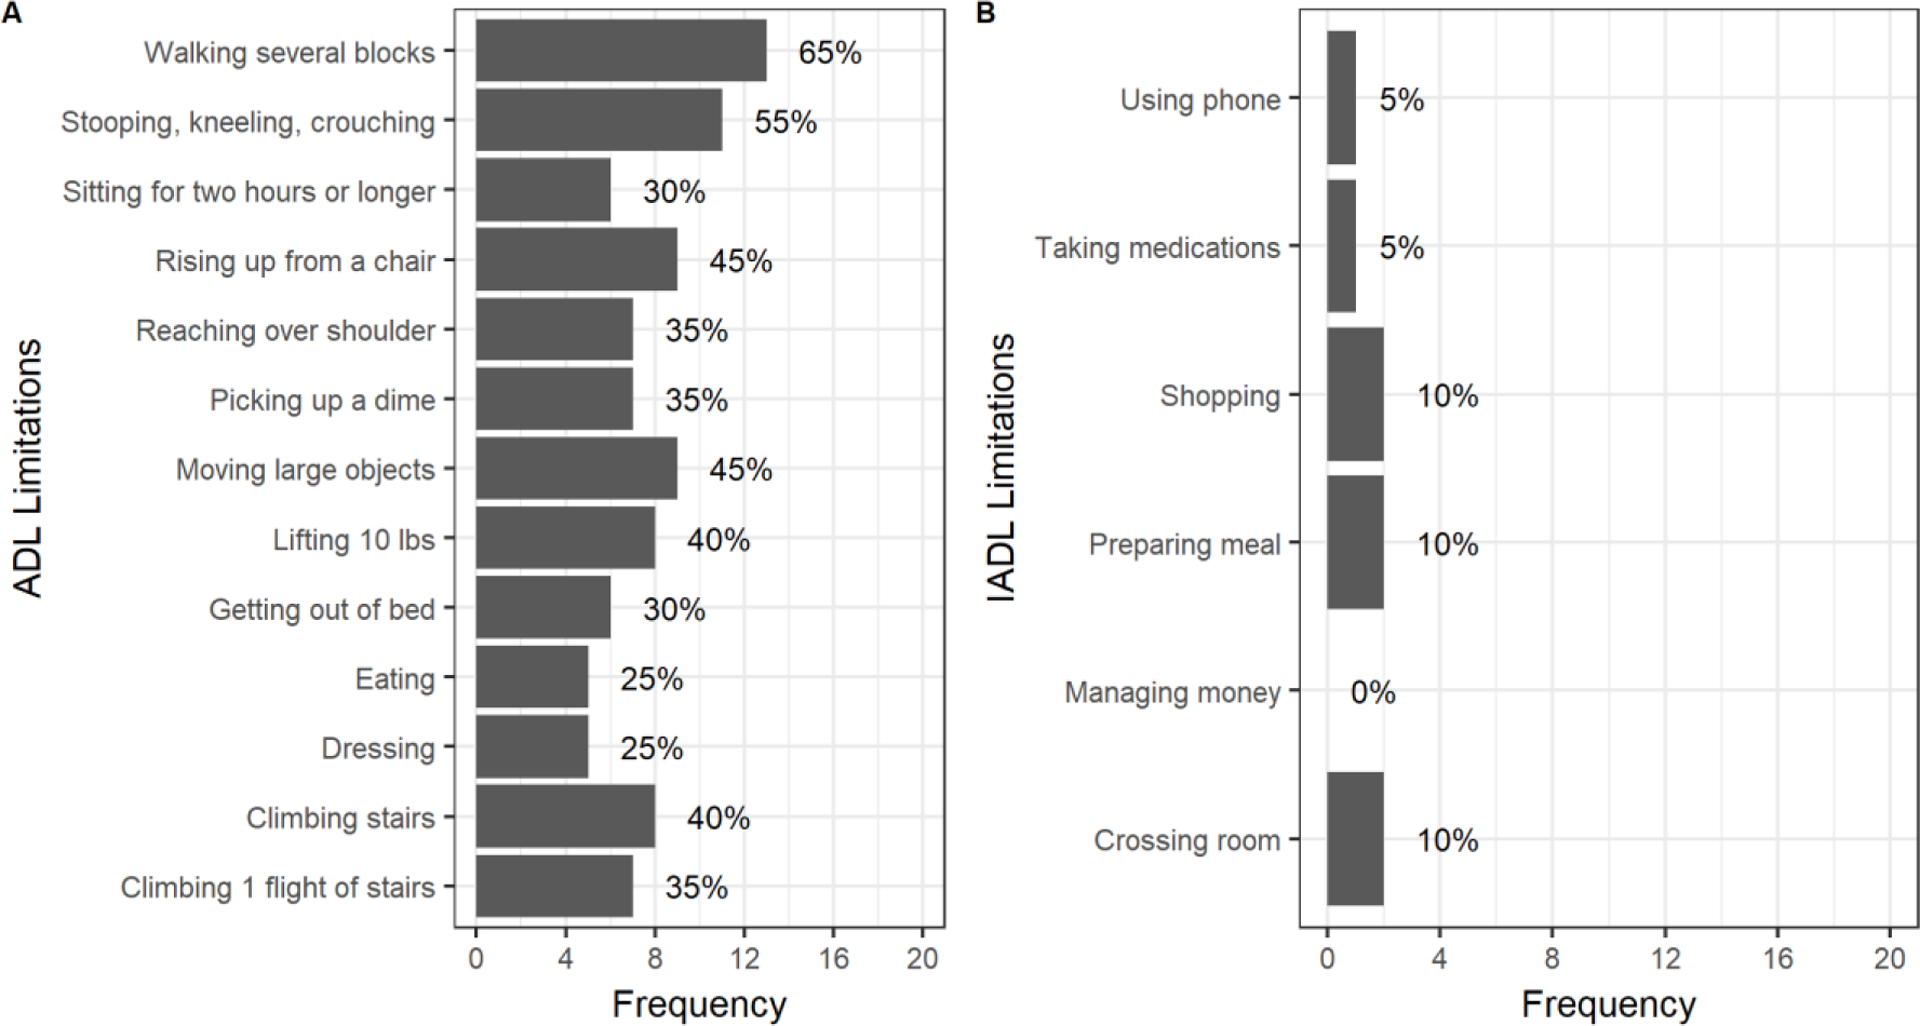
Activities of daily living (ADL) and instrumental activities of daily living (IADL) in older women with urinary incontinence